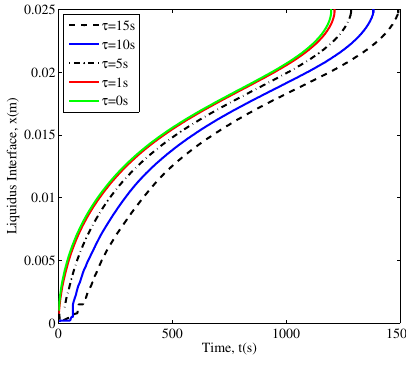
Figure 4. Liquidus interface position for the value of τ = 15 s , τ = 10 s , τ = 5 s , τ = 1 s , τ = 0 s .